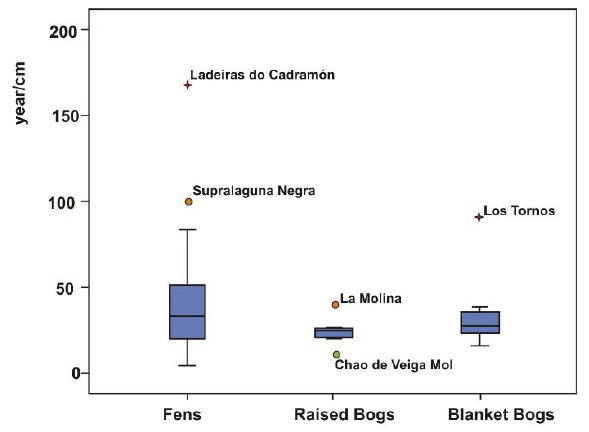
Figure 3. Vertical peat accumulation rates in the Iberian peatlands considered in this study. Stars indicate severe outliers. Circles indicate outliers with slightly higher (orange) and slightly lower (green) accumulation rates than the median.